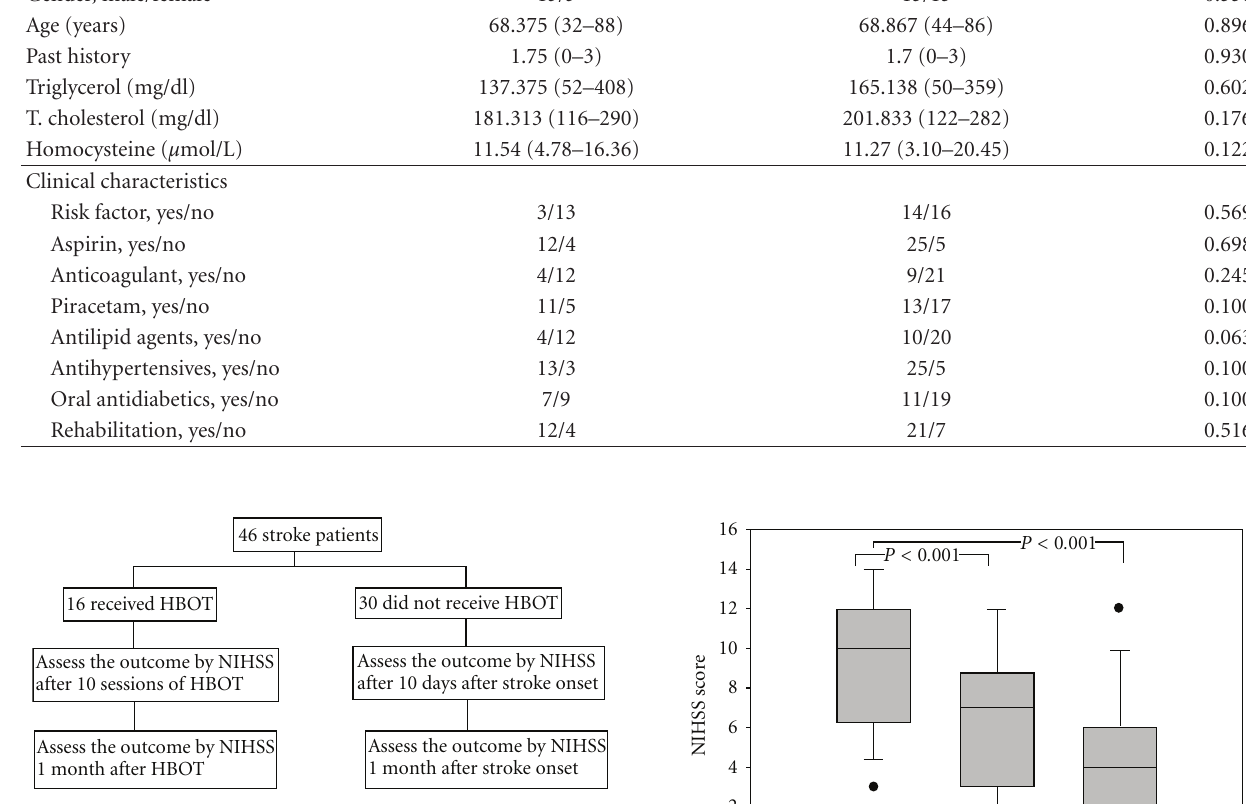
Figure 1: Hyperbaric oxygen therapy in acute ischemic stroke trial.